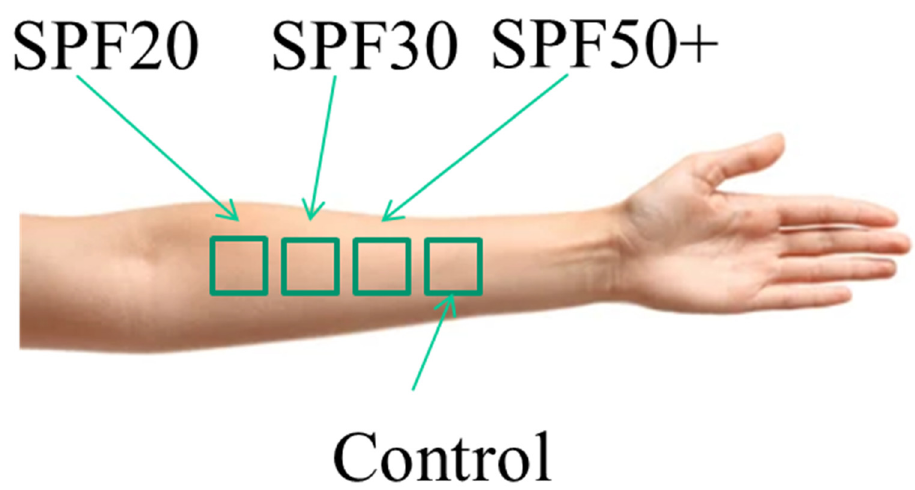
Figure 2. Four skin sites on the volar forearm. Three were test sites for sunscreen with SPF 20, 30, and 50+. The fourth skin site was chosen as the control.